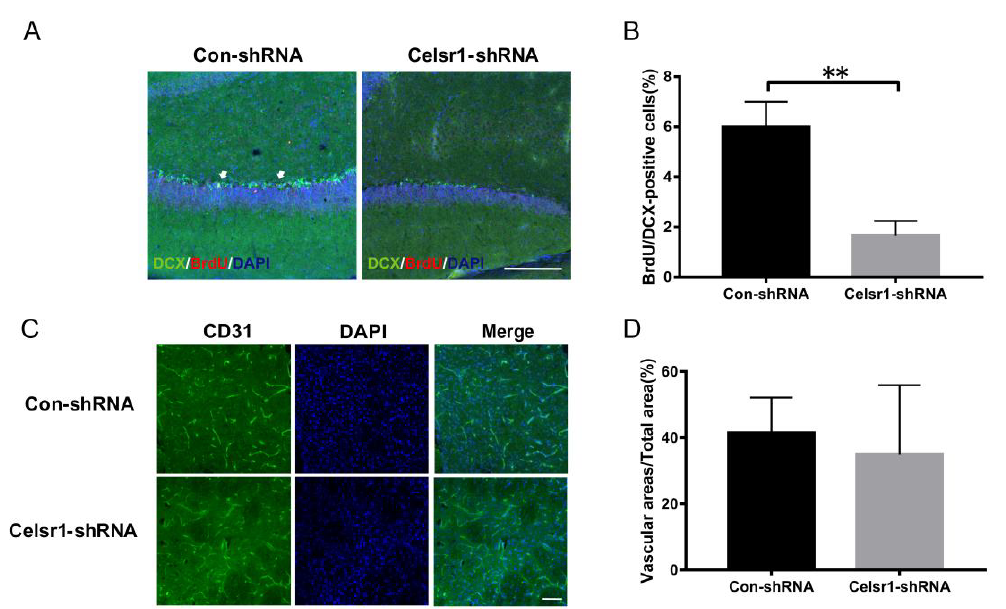
Figure 7. Celsr1 knockdown in the DG promoted neurogenesis but not angiogenesis. ( A ) The number of BrdU (red) / DCX (green)-positive cells was significantly reduced in the Celsr1 -shRNA group. Scale bar = 50 µ m. ( B ) Quantitative analysis of BrdU / DCX-positive cells in the DG ( n = 3 per group). ** p < 0.01. ( C ) CD31 staining in the ischemic penumbra upon Celsr1 knockdown in the DG. Scale bar = 45 µ m. ( D ) Quantitative analysis of CD31-positive cells in the ischemic penumbra ( n = 3 per group).